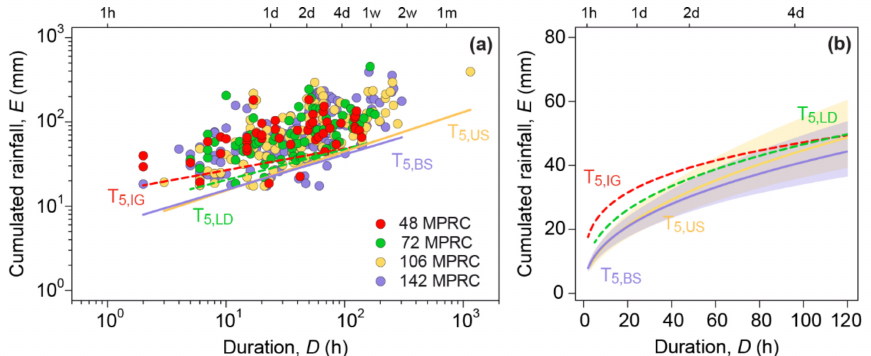
Figure 7. ( a ) Log–log plot with the ED (cumulated event rainfall—duration) conditions that triggered landslides in Slovenia classified in four geological classes and corresponding 5% thresholds (T 5,IG , T 5,LD , T 5,US , T 5,BS ). ( b ) Same thresholds and related uncertainties (shaded areas) in the range 1 h ≤ D ≤ 120 h in linear coordinates. The thresholds with not-acceptable uncertainties are indicated with dotted